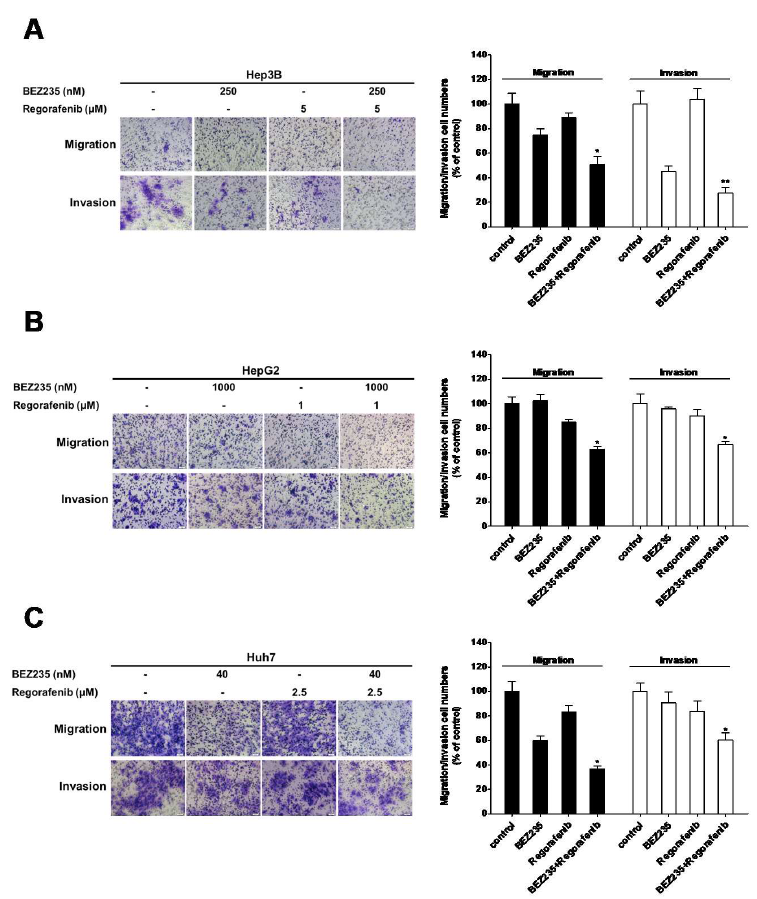
Figure 3. Treatment with BEZ235 enhances the anti-migration and -invasion effect of regorafenib in HCC cells. The analysis of transwell migration and invasion assay upon treatment of Hep3B ( A ), HepG2 ( B ) and Huh7 ( C ) cells with BEZ235 and regorafenib for 24 h or 48 h. Data are represented as means ± S.D. * p < 0.05, and ** p < 0.01 versus untreated control, BEZ235 or regorafenib alone